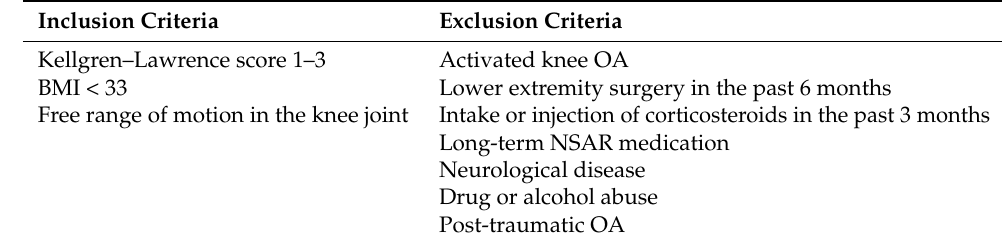
Table 2. Inclusion and exclusion criteria for patient